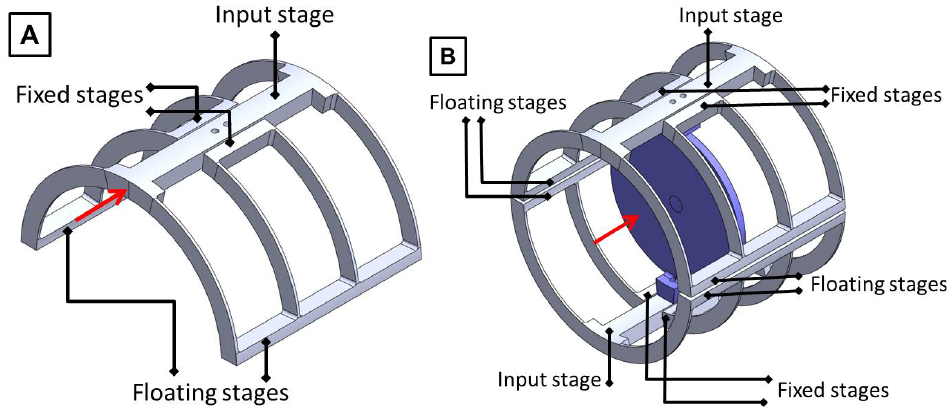
Figure 9. (A) Double curved compound-spring. (B) Stage driven by two separate double curved compound-springs, the quad compound- spring CF design.